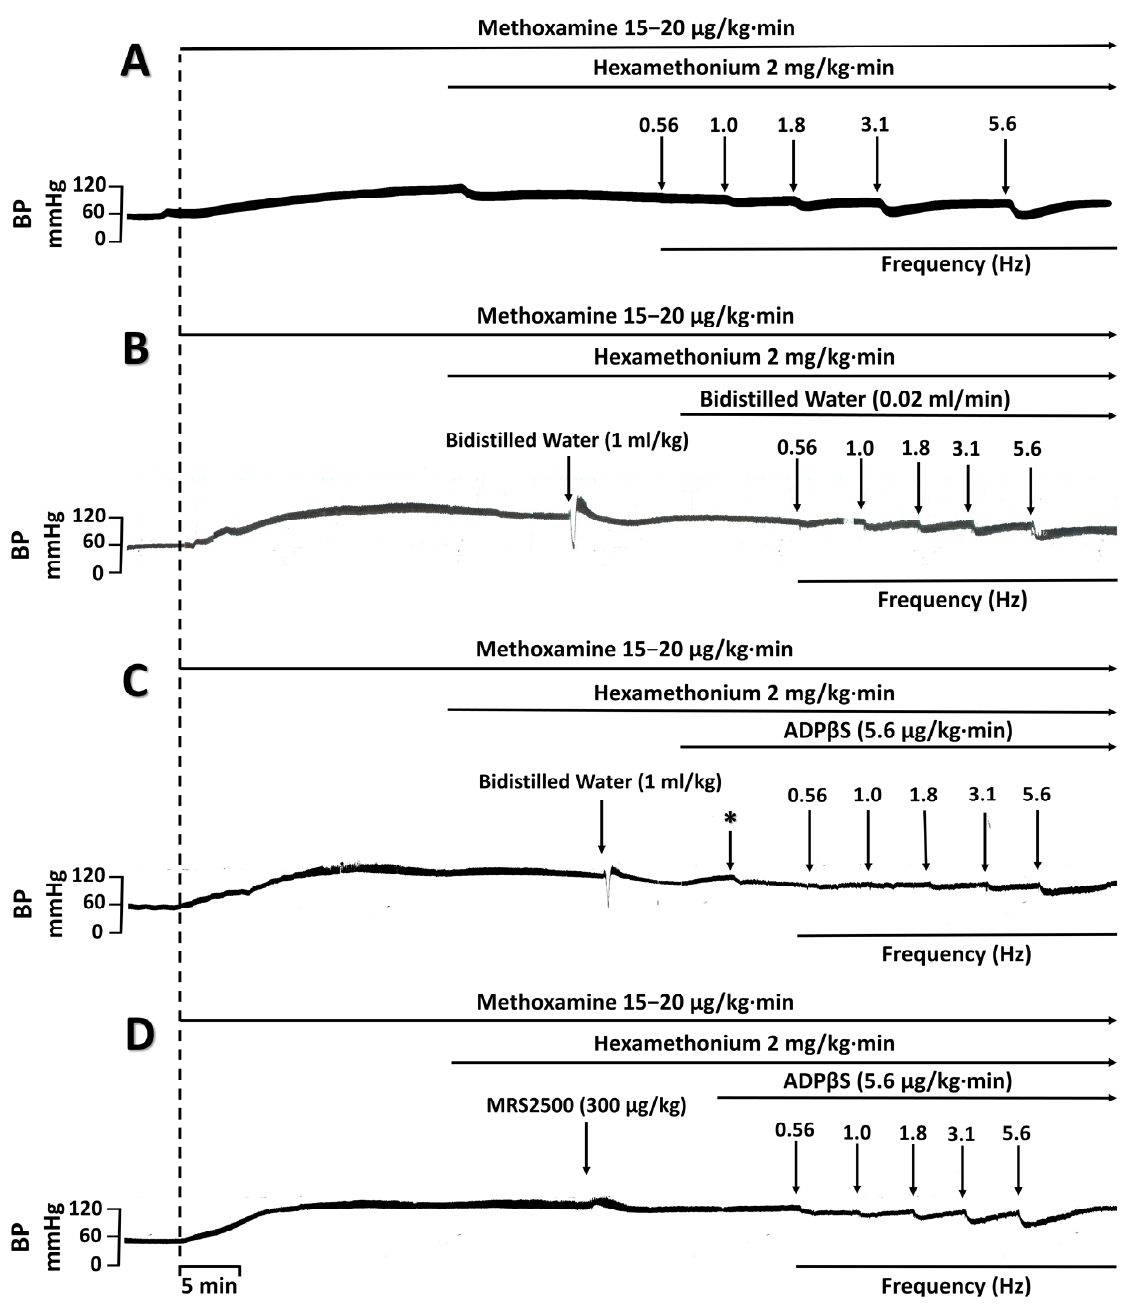
Figure 4. Experimental tracings of the vasodepressor responses by electrical stimulation of the vasodepressor sensory CGRPergic drive under different conditions. S-R curves of the vasodepressor responses (peak changes) by electrical stimulation of the perivascular sensory CGRPergic nerves in pithed rats with ( A ) no treatment (control); ( B ) i.v. bolus (after 10 min) of bidistilled water followed by i.v. infusions (after 10 min) of bidistilled water; ( C ) i.v. bolus (after 10 min) of bidistilled water followed by an i.v. infusion (after 10 min) of ADP β S (5.6 μ g/kg ∙ min); and ( D ) i.v. administration (after 10 min) of MRS2500 (300 μ g/kg) followed by an infusion (after 10 min) of ADP β S (5.6 μ g/kg ∙ min). As shown in panel C, the ADP β S infusion (after 10 min) (i) produced a decrease in DBP (*, 19 ± 3 %; p < 0.05; Table 1); and (ii) inhibited the electrically ‐ induced vasodepressor CGRPergic responses. Panel D also shows that these effects of ADP β S were blocked following i.v. administra ‐ tion (after 10 min) of MRS2500 (300 μ g/kg). BP stands for blood pressure. Similar results were ob ‐ served after each treatment (n = 6 for each subgroup).